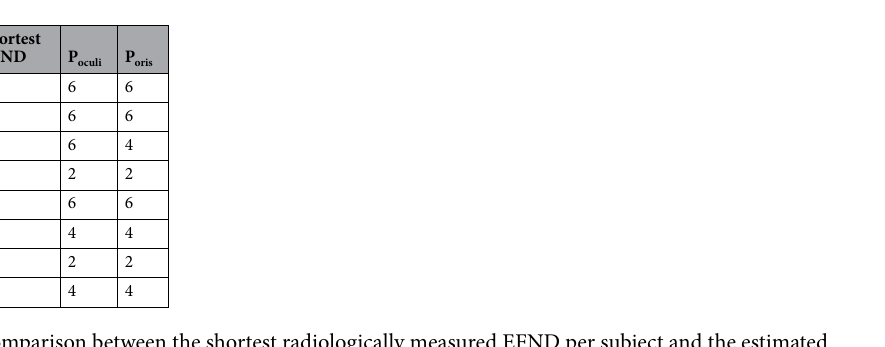
Figure 6. Normalized EMG responses during the stepwise electrode insertion in 8 subjects. The EMG responses are shown as function of the number of inserted electrode contacts. The solid and dashed lines correspond to the periocular and perioral EMG channel, respectively. Normalization assigned the value 0 to the lowest amplitude and 1 to the maximum amplitude.